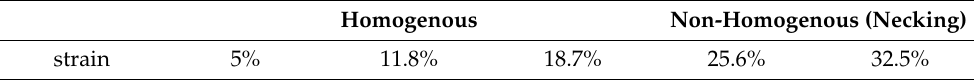
Table 1. Predefined plastic strains.